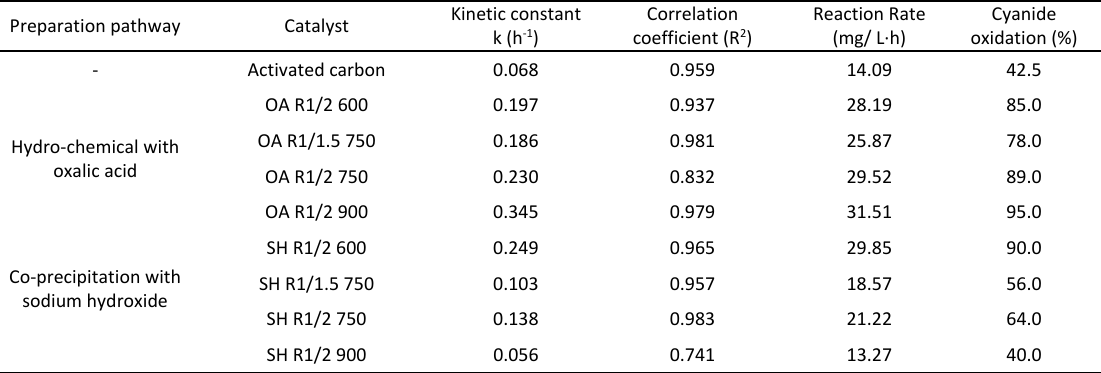
Table 2: Parameters of the reaction kinetics of the prepared catalysts